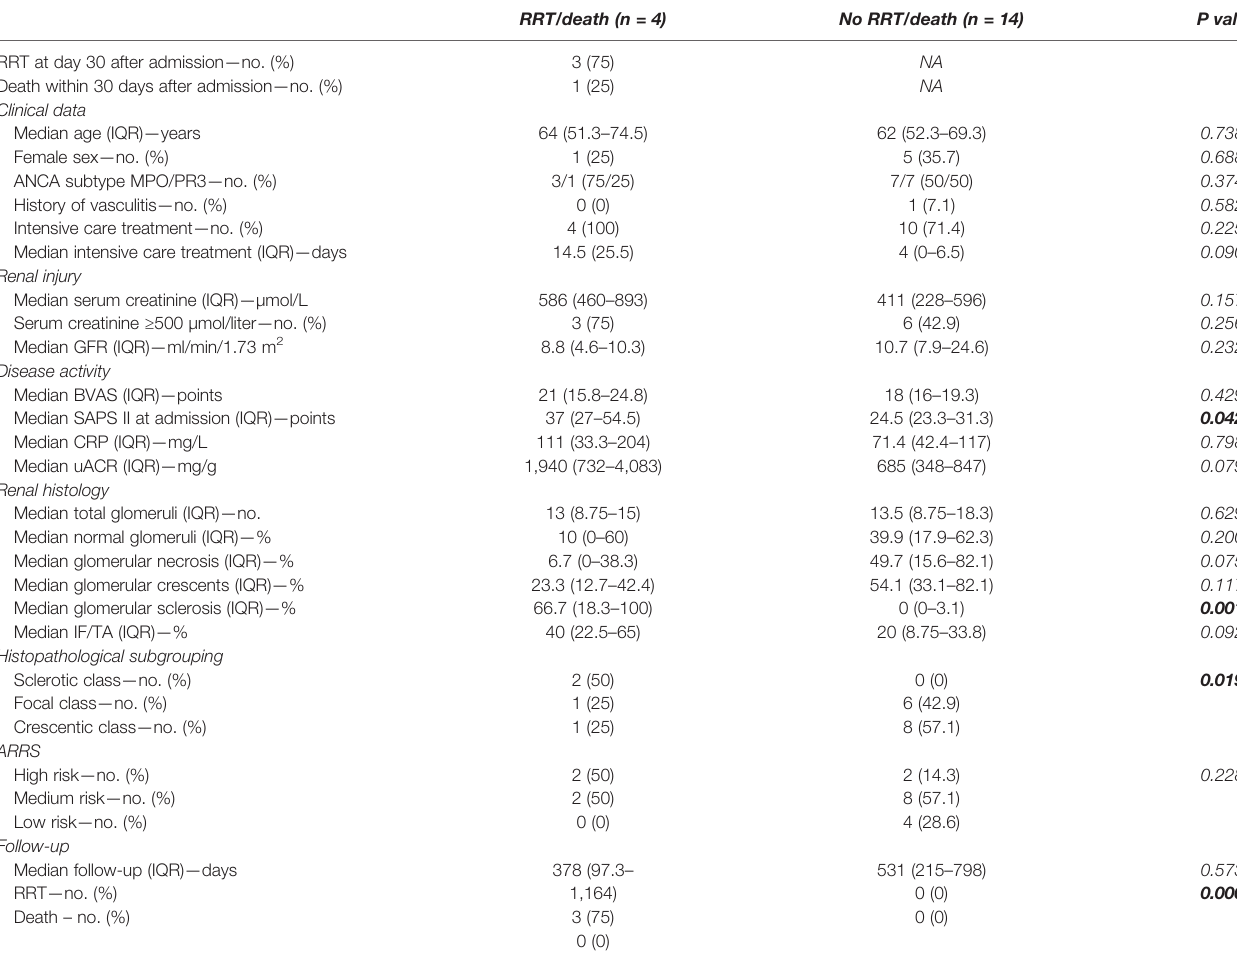
TABLE 3 | Characteristics of patients receiving PEX: short-term outcome within 30